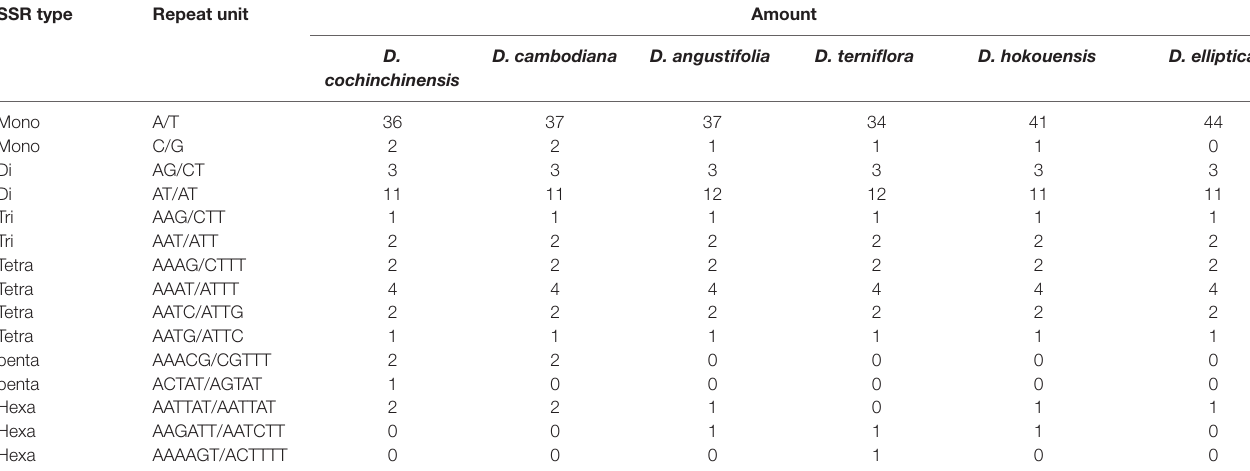
TaBLe 3 | The simple sequence repeat (SSR) types of the six CP genomes of Dracaena